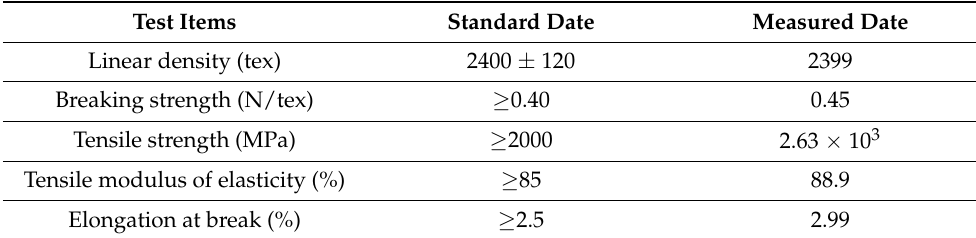
Table 5. Physical properties of the PVA